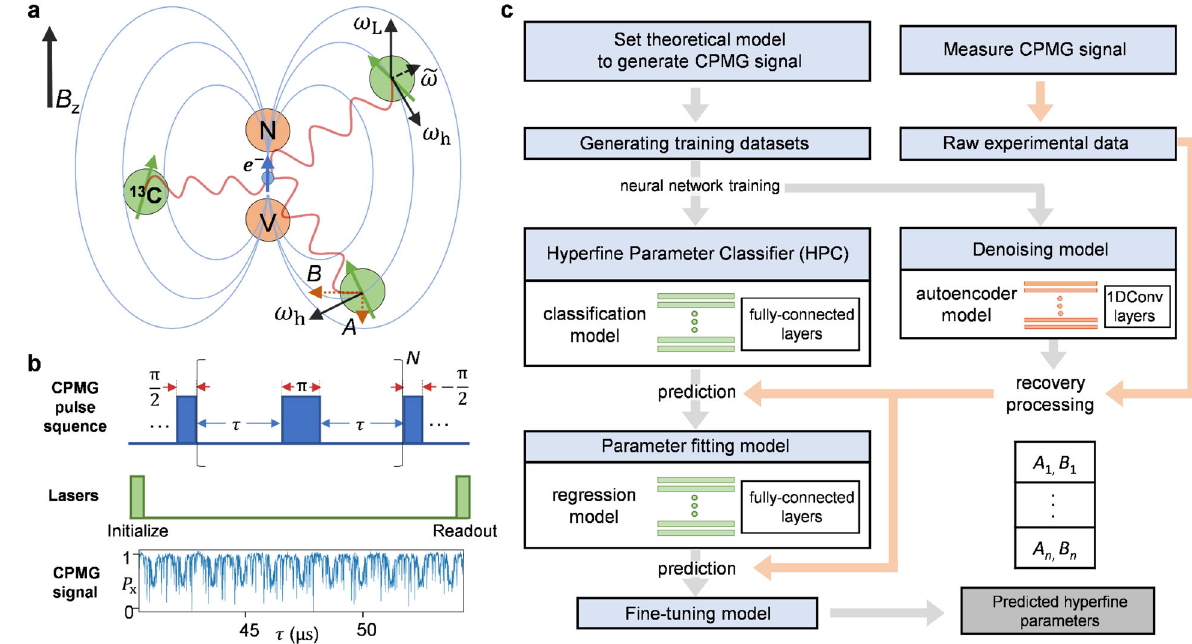
Fig. 1 General procedure for identifying hyper fi ne parameters of 13 C nuclear spins. a Schematic diagram showing the con fi guration of an electron spin within the nitrogen-vacancy (NV) center magnetic dipole fi eld (blue oval curves) and 13 C nuclear spins (green circles) interacting with the NV center via hyper fi ne interaction. B z is the external magnetic fi eld strength, ω L is the Larmor frequency, ω h ¼ q ffiffiffiffiffiffiffiffiffiffiffiffiffiffiffiffiffiffiffiffiffiffiffiffiffiffiffiffiffiffi ~ ω ¼ Þ 2 þ B 2 ð A þ ω where A ( B ) is the longitudinal (transverse) hyper fi ne interaction parameter. b Typical dynamical decoupling pulse L sequence (Carr-Purcell-Meiboom-Gill, CPMG) used for experimental nuclear spectroscopy. The bottom panel shows an example of experimental CPMG data from which electron-nuclear hyper fi ne interaction is analyzed. c Pseudo-algorithm for training and hyper fi ne- parameters-prediction sequences including hyper fi ne parameter classi fi er (HPC), denoise and signal recovery, regression-based fi tting, and fi ne-tuning models. The fl ow of experimental processes (computational processes) is on the red (gray)